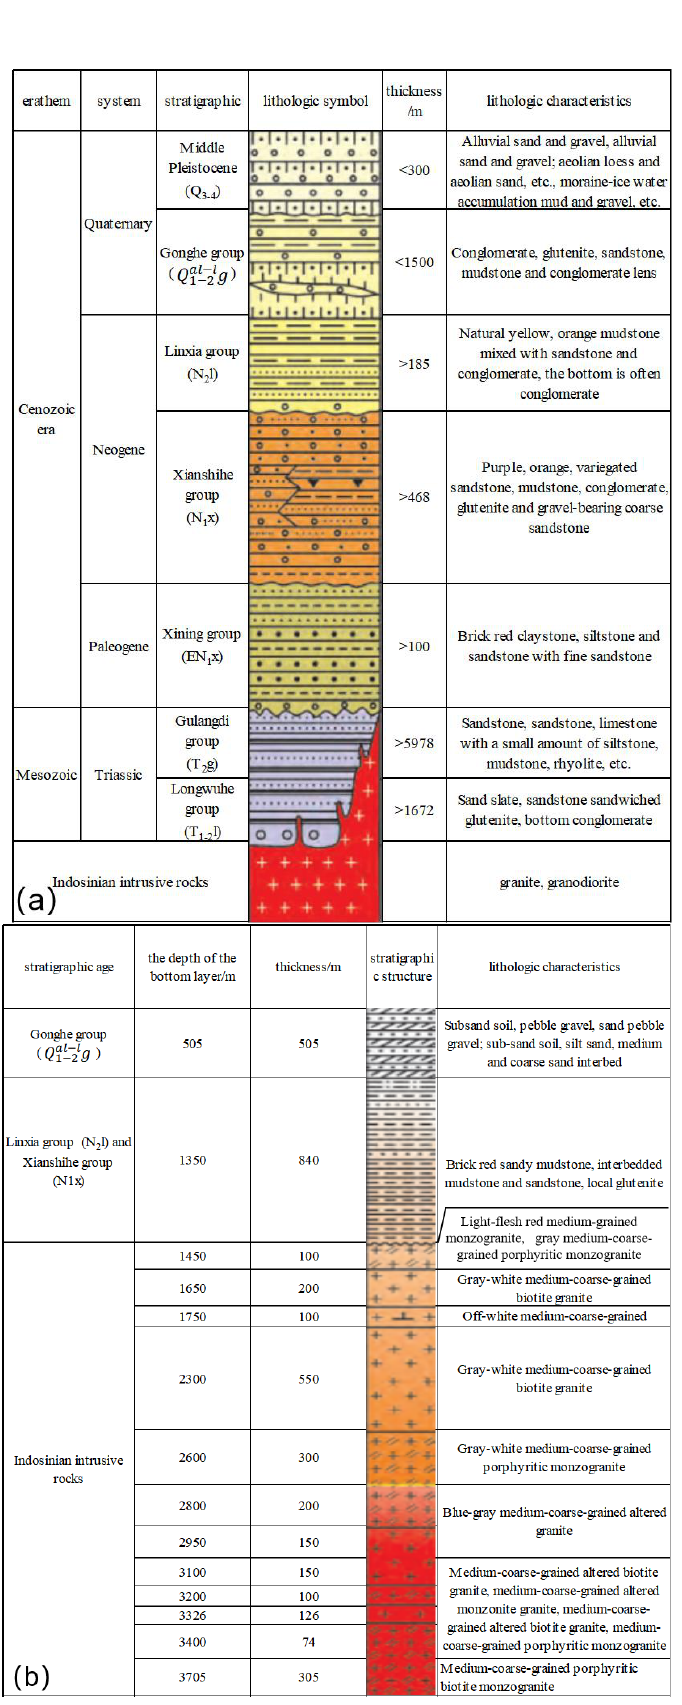
Figure 2. ( a ) Strata in Gonghe area, ( b ) Strata of